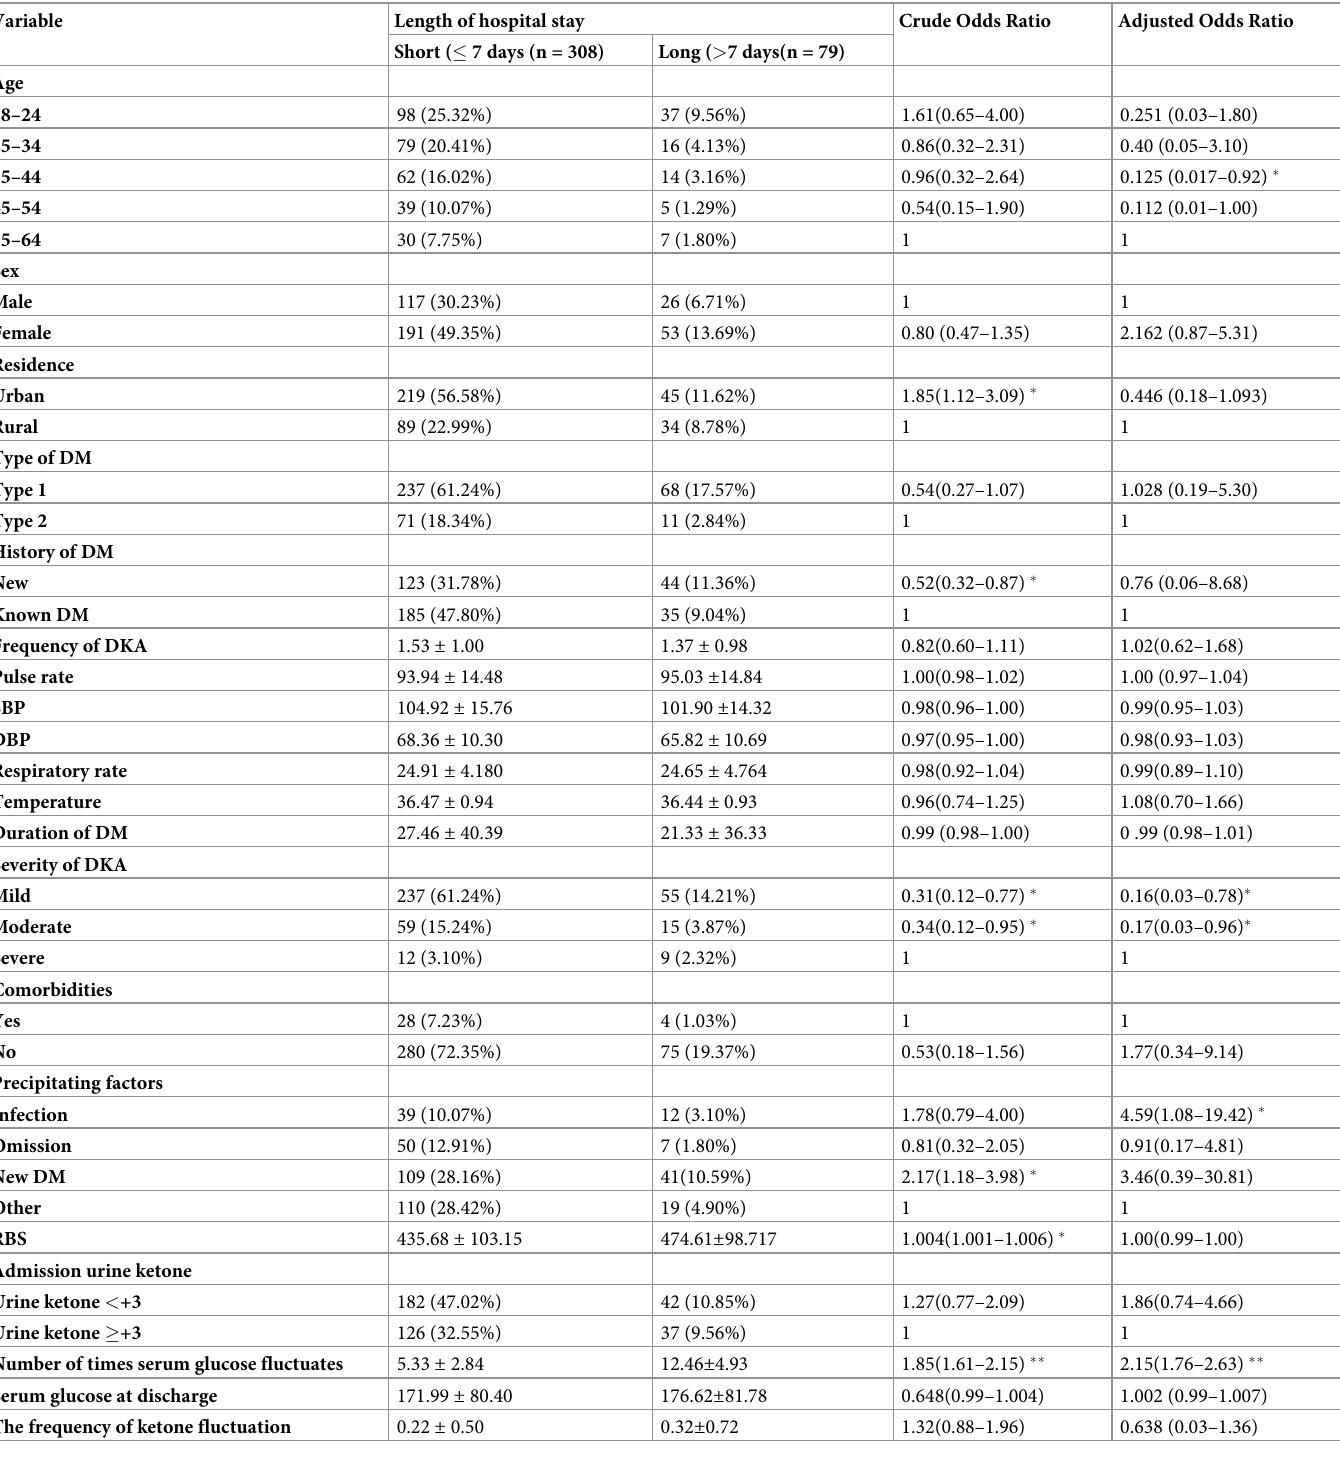
Table 5. Determinants of hospital stay in DKA patients at DTGH from August 2010 to May 31, 2018(n =